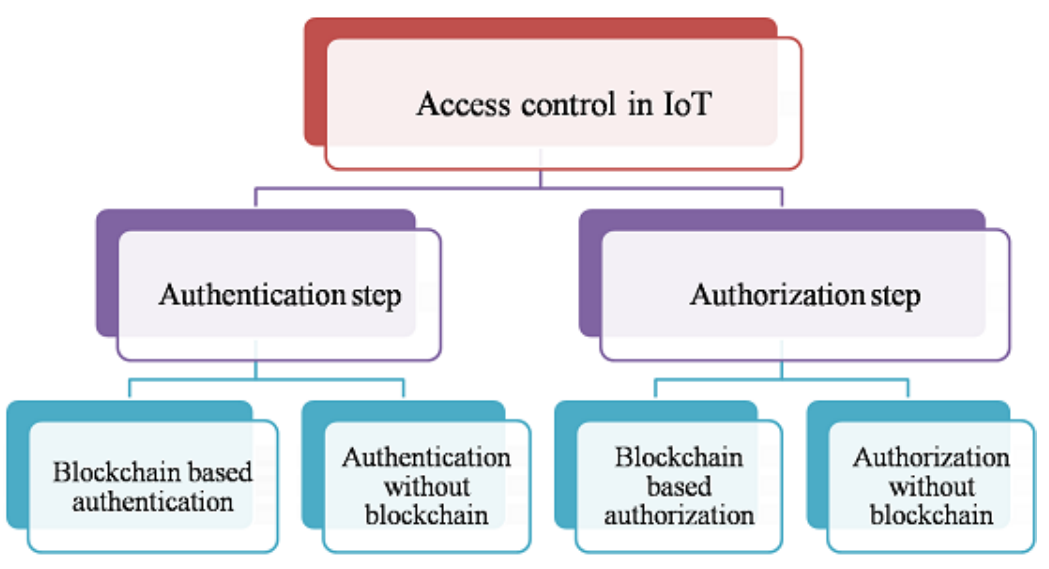
Figure 6. Access control